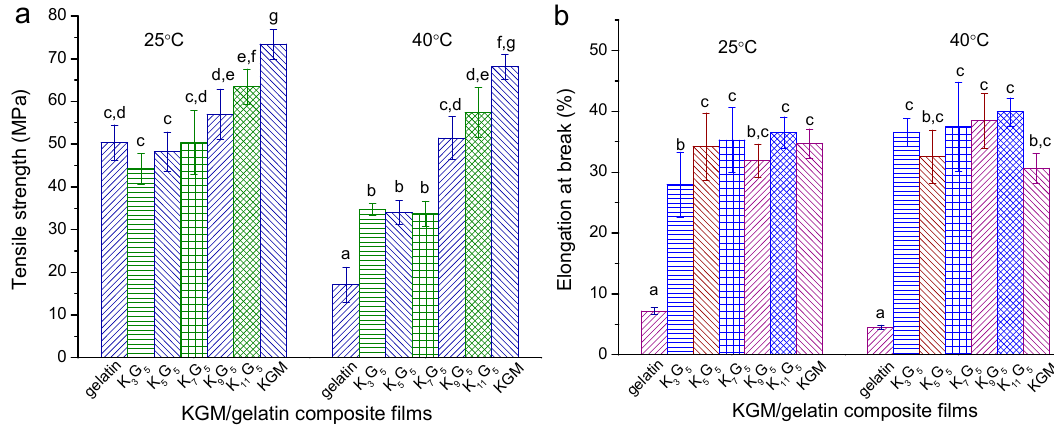
Figure 5. Tensile strength ( σ t) and elongation at break ( ε b ) for KGM, gelatin, and KGM / gelatin films prepared with drying temperatures of 25 ◦ C ( a ) and 40 ◦ C ( b ). Values with the di ff erent lowercase letters letter in each figure di ff er significantly at p < 0.05.